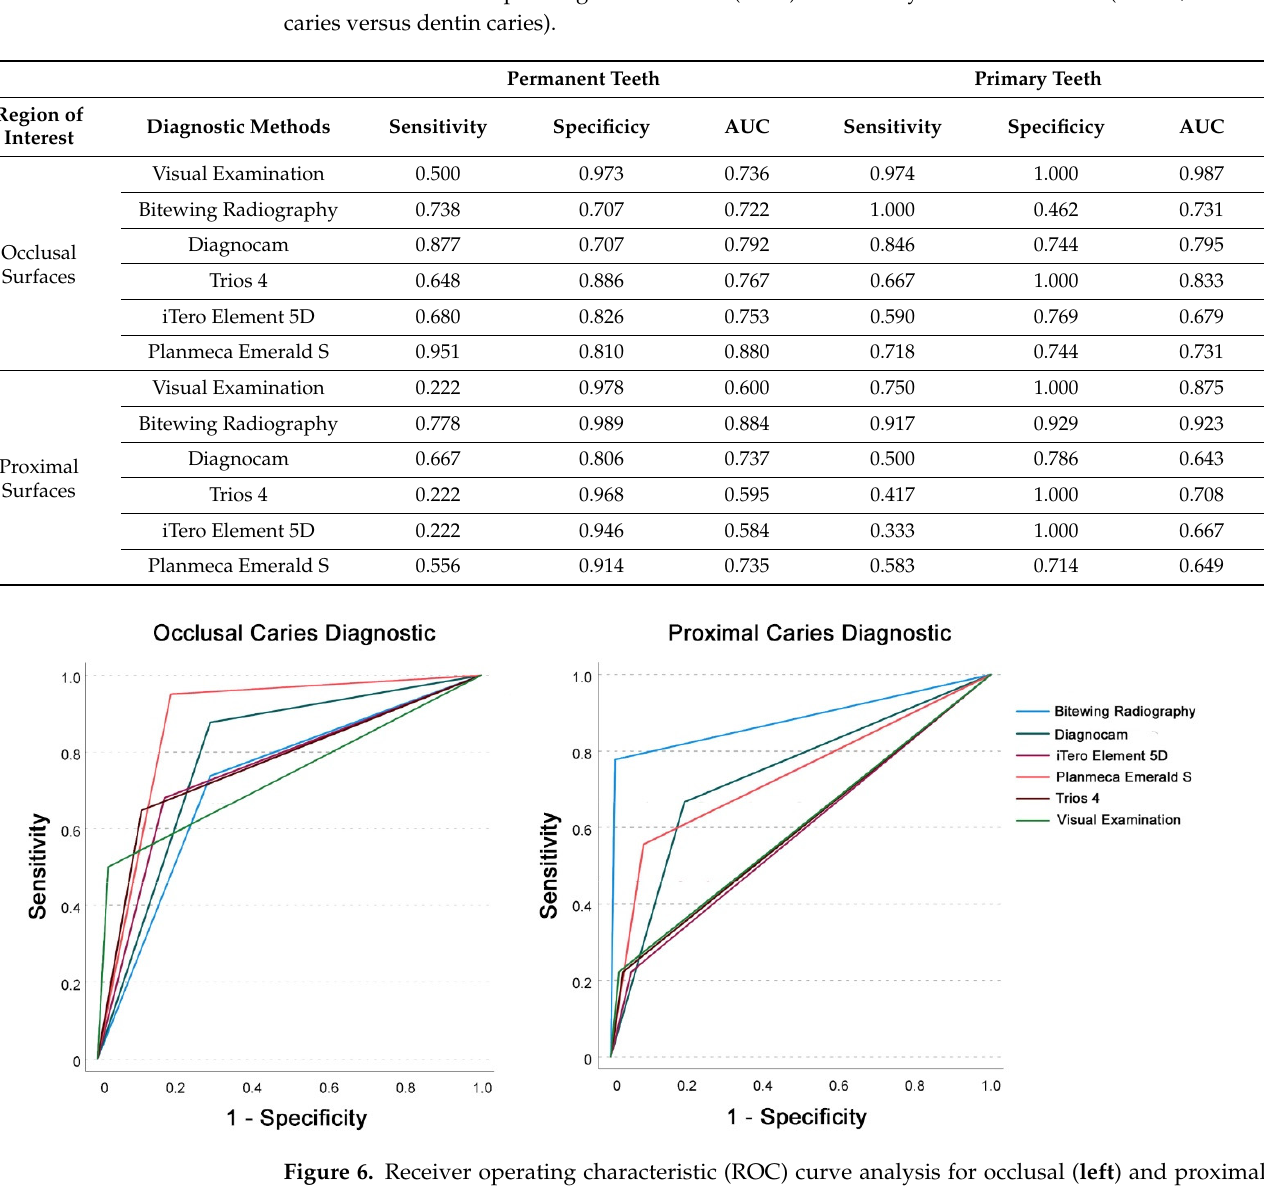
Figure 7. Receiver operating characteristic (ROC) curve analysis for occlusal ( left ) and proximal ( right ) caries diagnostics for the investigated diagnostic methods in primary teeth with threshold II (sound/enamel caries versus dentin caries). 3.3. Logistic Regression Data from all caries diagnostic methods were compared to the reference µ-CT. For occlusal caries diagnostics in permanent teeth, visual examination showed the lowest mean deviation on sound surfaces (1 ± 9.3%). On surfaces with caries, the Planmeca Em- erald S revealed the lowest mean deviation (5 ± 21.7%).